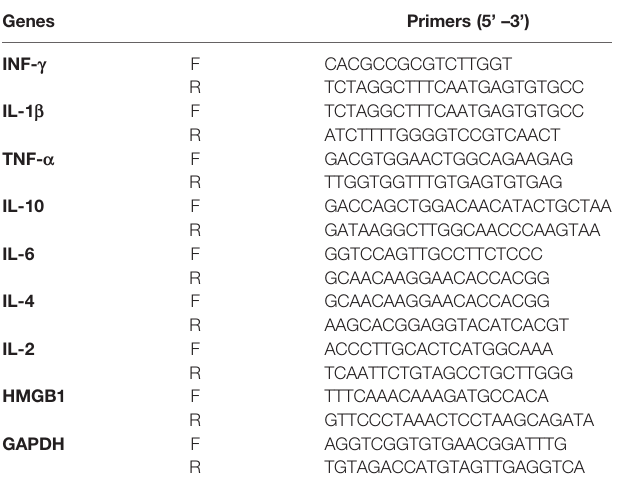
TABLE 1 | Primers for